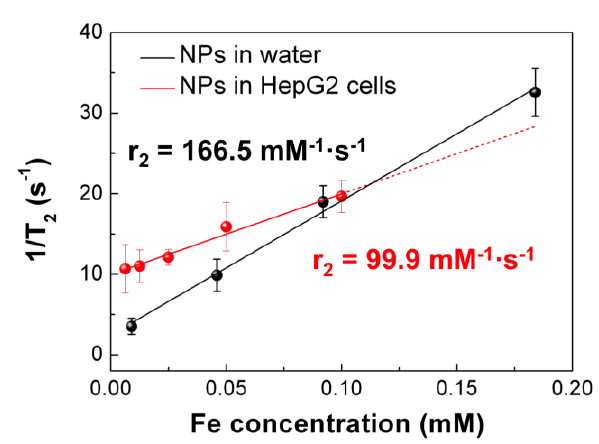
Figure 9. Proton T 2 relaxation time in magnetic resonance imaging (MRI) as a function of iron concentration for NPs in water and in HepG2 cells. The r 2 value is determined by the slope of the linear fit.